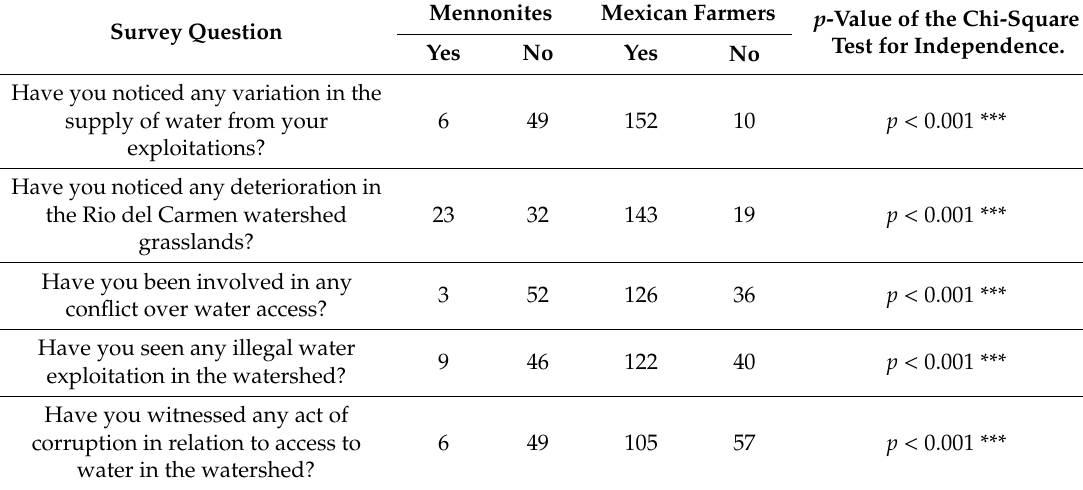
Table 3. Survey results that present the di ff erent perceptions between the Mennonites and the Mexican farmers in the Rio del Carmen watershed, over the same issues and the same period of time (1997–2017), with the p -value of the chi-square test for independence. Three asterisks mean that there is a significant di ff erence between perceptions of the two groups of farmers, so the null hypothesis that states that that both communities are equal in relation to their perceptions cannot be